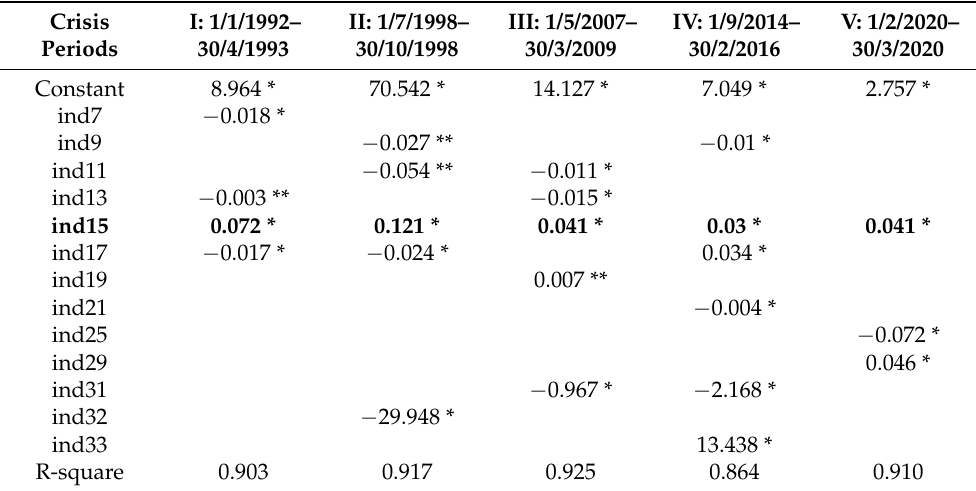
Table 6. Indexes in multiple linear regression models of Toronto-Dominion Bank during the 5 crisis